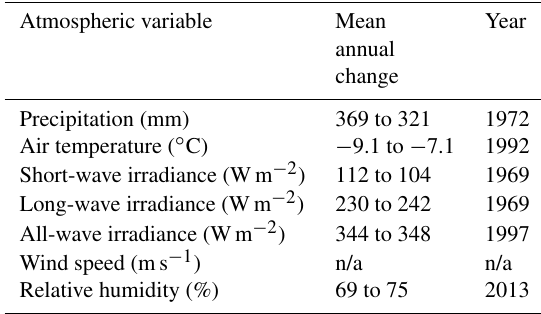
Table 3. Mean change point analysis of the atmospheric forcing variables.